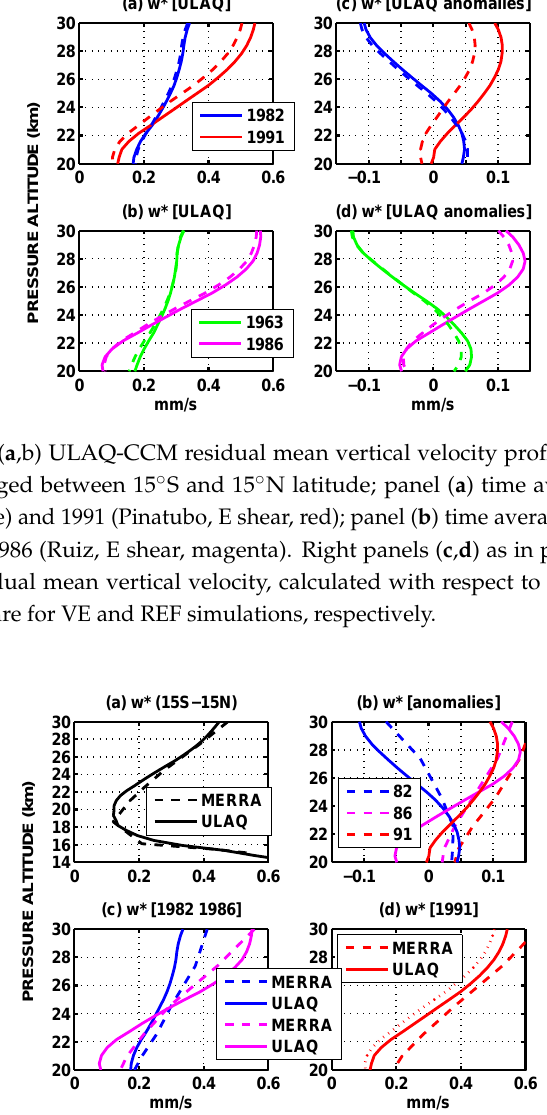
Figure 9. Panel ( a ) evaluation of the ULAQ-CCM lower stratospheric tropical upwelling (solid line, VE simulation) with MERRA reanalysis data (dashed line), in terms of the residual mean vertical velocity profile (mm/s) (15 ˝ S ´ 15 ˝ N latitudinal average). Velocity profiles are averaged from 1979 to 2000 for both ULAQ-CCM and MERRA. Panel ( b ) as in ( a ), but for the anomalies of the residual vertical velocity with respect to the long-term averages of panel ( a ), calculated during 1982 (El Chichón, W shear, blue), 1986 (Ruiz, E shear, magenta) and 1991 (Pinatubo, E shear, red). Panels ( c , d ) as in panel ( a ), but for years 1982 (El Chichón, W shear, blue) and 1986 (Ruiz, E shear, magenta) in ( c ); and for 1991 (Pinatubo, E shear, red) in ( d ). Solid/dashed curves are for ULAQ-CCM (VE simulations) and MERRA data, respectively. The dotted line in panel ( d ) shows the ULAQ-CCM 1991 results for the REF